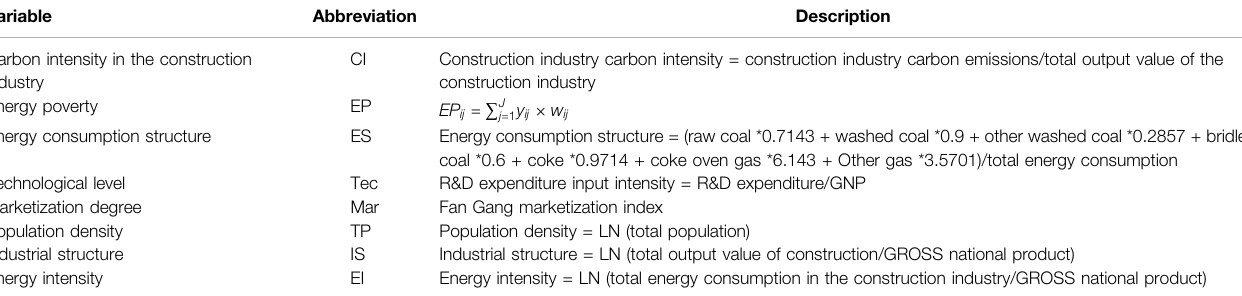
TABLE 1 | Variable de fi nition table. Variable Abbreviation